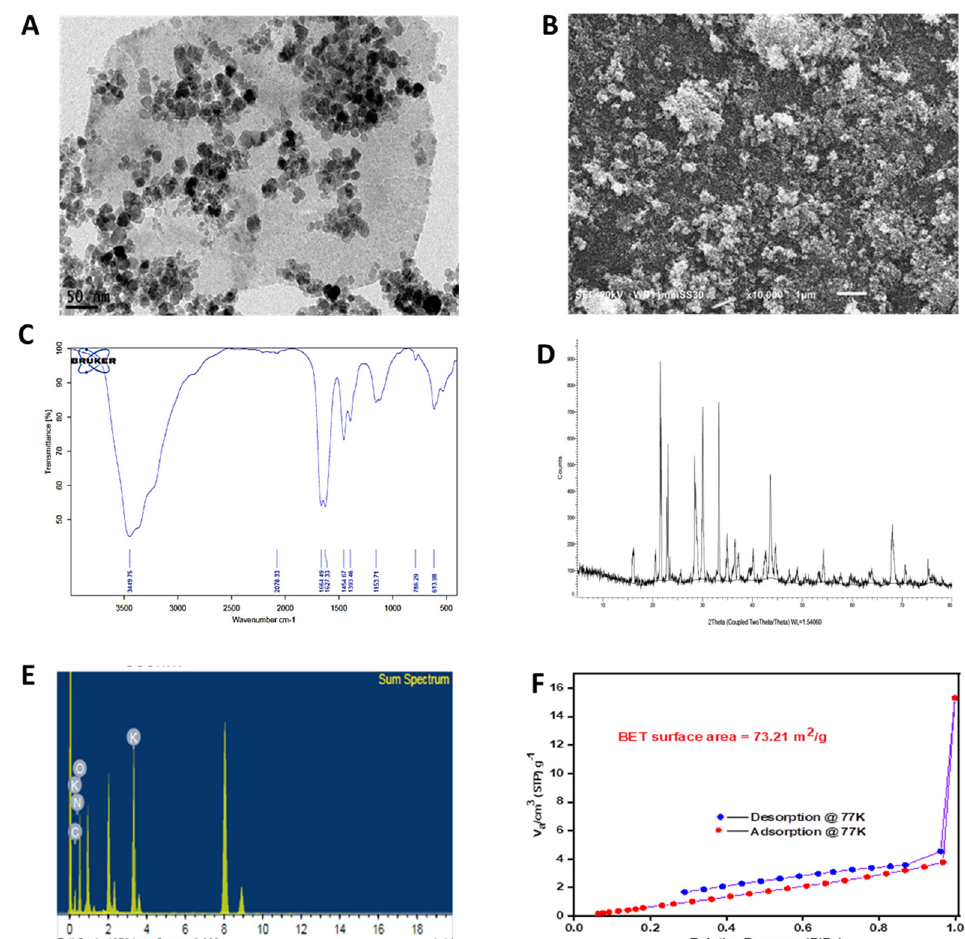
Figure 1. Characterization of chitosan nanoparticles fabricated by Penicillium oxalicum from shrimp waste ( A ) and ( B ) TEM and SEM images, ( C ) FTIR images for active groups in chitosan nanoparticles, ( D ) XRD of chitosan nanoparticles, © the energy dispersive X-ray (EDX) for chitosan nanoparticles ( E ) N 2 adsorption-desorption isotherms of the fabricated chitosan nanoparticles ( F ) .